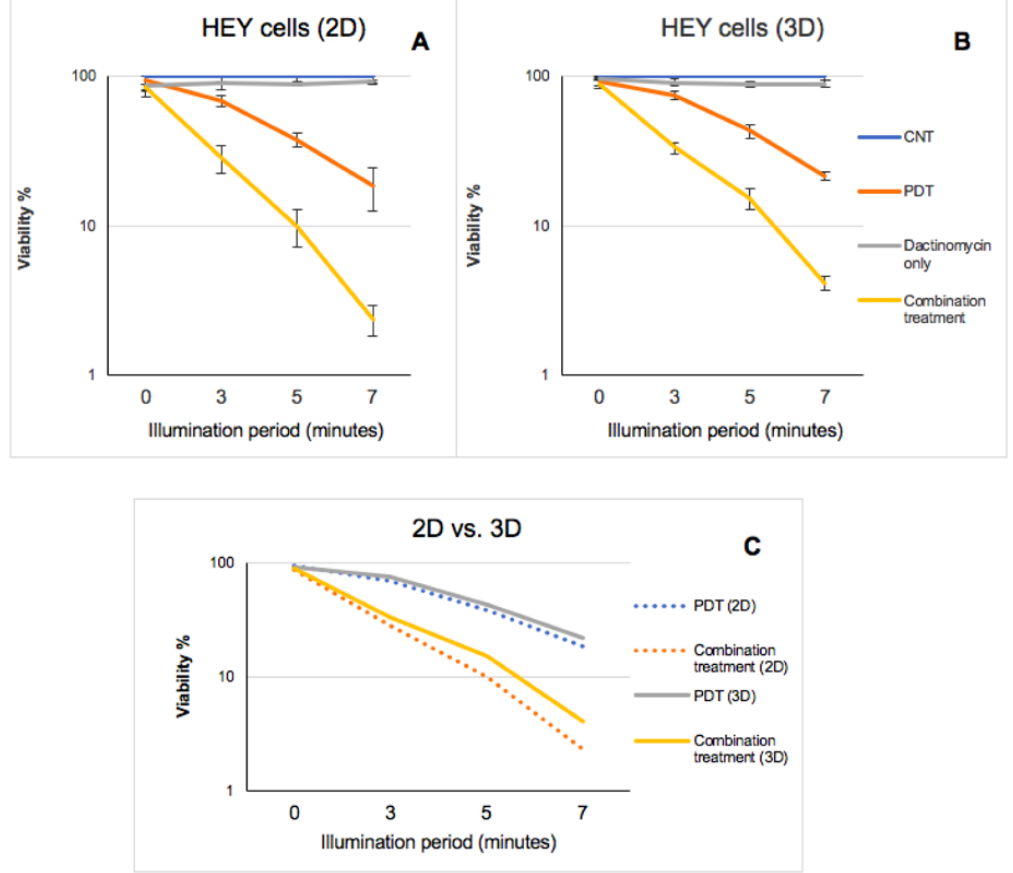
Figure 6. Semi-logarithmic graph comparing the effect of PDT, Dactinomycin only and combination treatment on viability of HEY cells in 2D ( A ) vs. 3D ( B ) cultures with increasing illumination periods. Graph ( C ) demonstrates a comparison of PDT and combination treatment effects on viability of HEY cells in each type of culture. The measurements were taken using Alamar Blue assay.